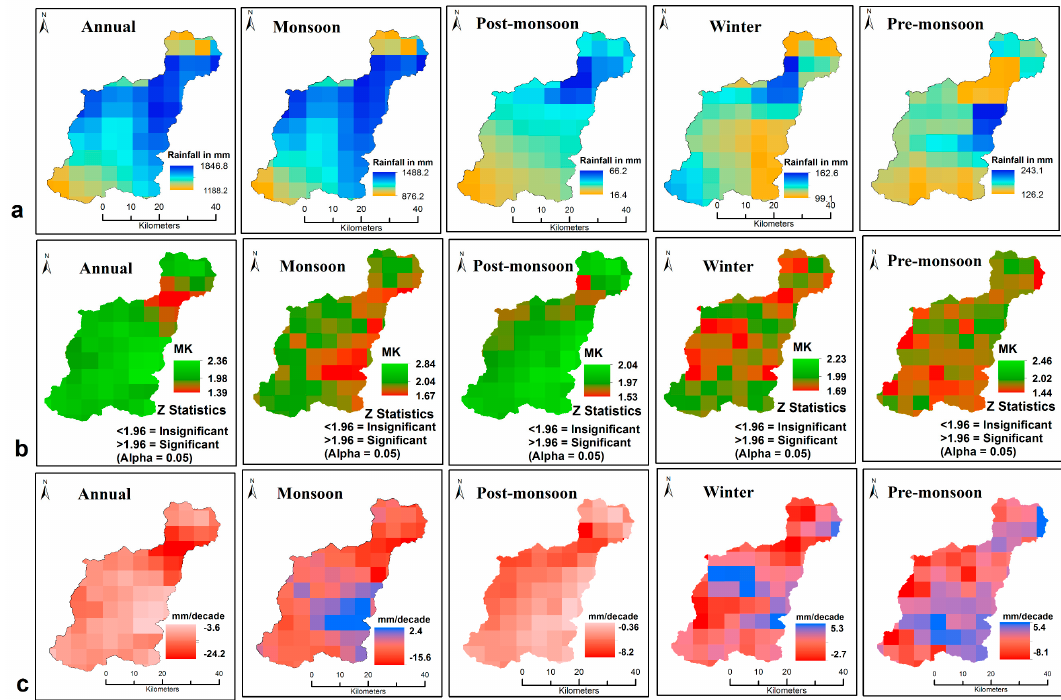
Figure 8. ( a ) Spatial distribution, ( b ) statistical significance level and ( c ) trends in annual and seasonal rainfall from 2009 to 2018 respectively. Top panel showing annual and seasonal rainfall distribution from 2009 to 2018, Middle panel indicate the level of significance (at 95% confidence level based on MK test), Bottom panel showing annual and seasonal trends of rainfall for the same period, where blue and red color indicates increasing and decreasing trends,